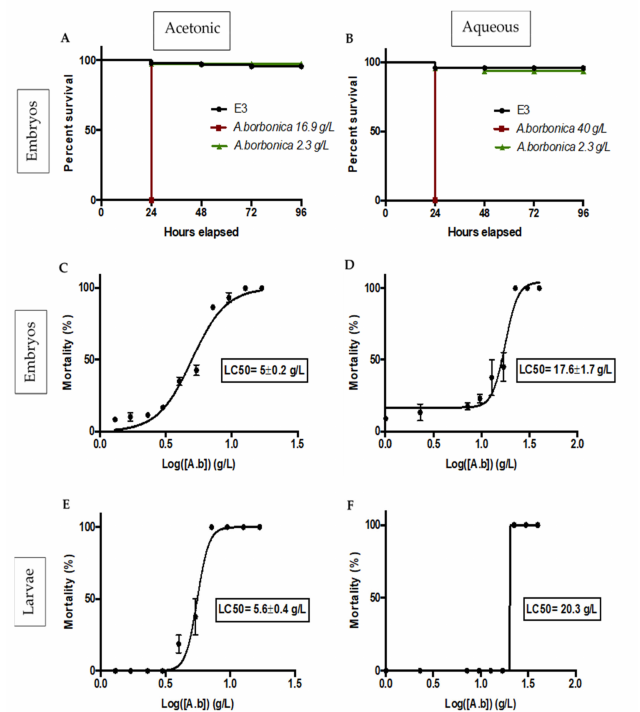
Figure 3. Survival curves for 96 hpf zebrafish embryos exposed with acetonic ( A ) or aqueous ( B ) extracts from A. borbonica at high concentrations of 16.9 g / L (acetonic) and 40 g / L (aqueous) and a low concentration of 2.3 g / L (acetonic and aqueous), and E3 was considered as control. Median lethal concentration curves (LC 50 ) for 96 hpf zebrafish embryos and 72 hpf larvae exposed to acetonic ( C , E ) or aqueous ( D , F ) extracts at di ff erent concentrations ranging from 16.9 to 1.3 g / L (acetonic) and 40 to 2.3 g / L (aqueous) for 4 and 2 days, respectively. The LC 50 values were expressed in g / L. Data are the mean ± SD of three independent experiments.